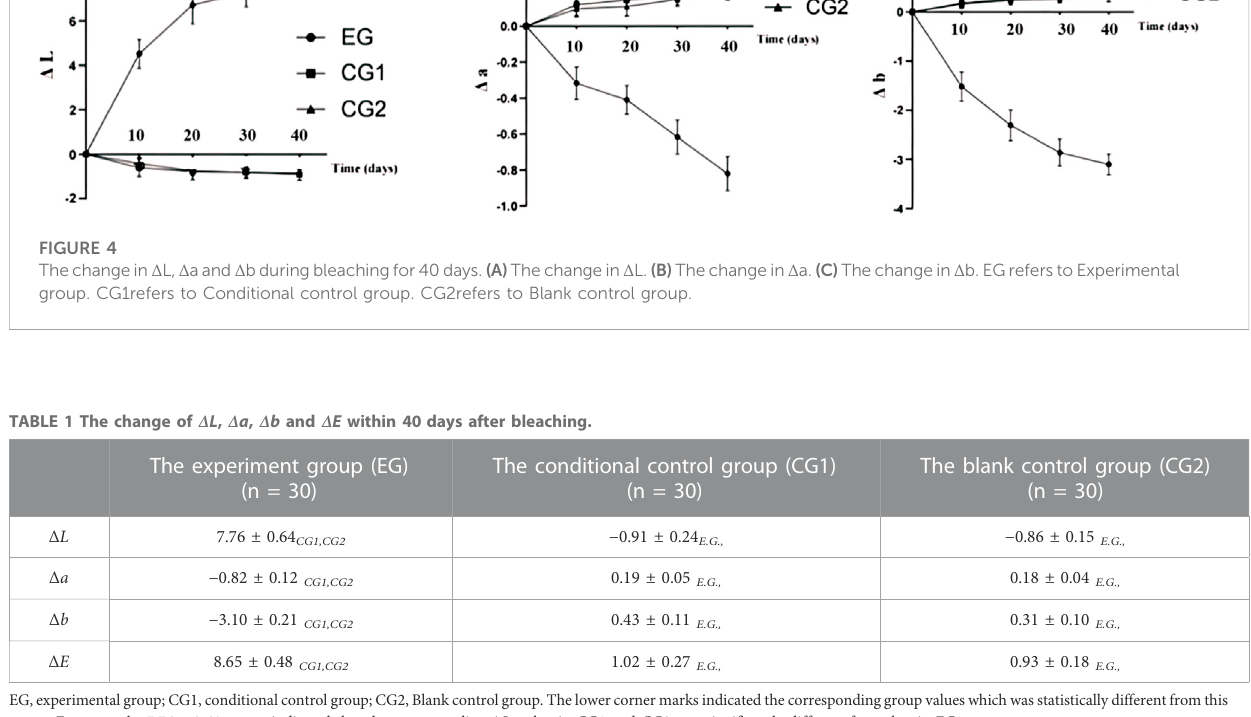
The blank control group (CG2) (n = 30)